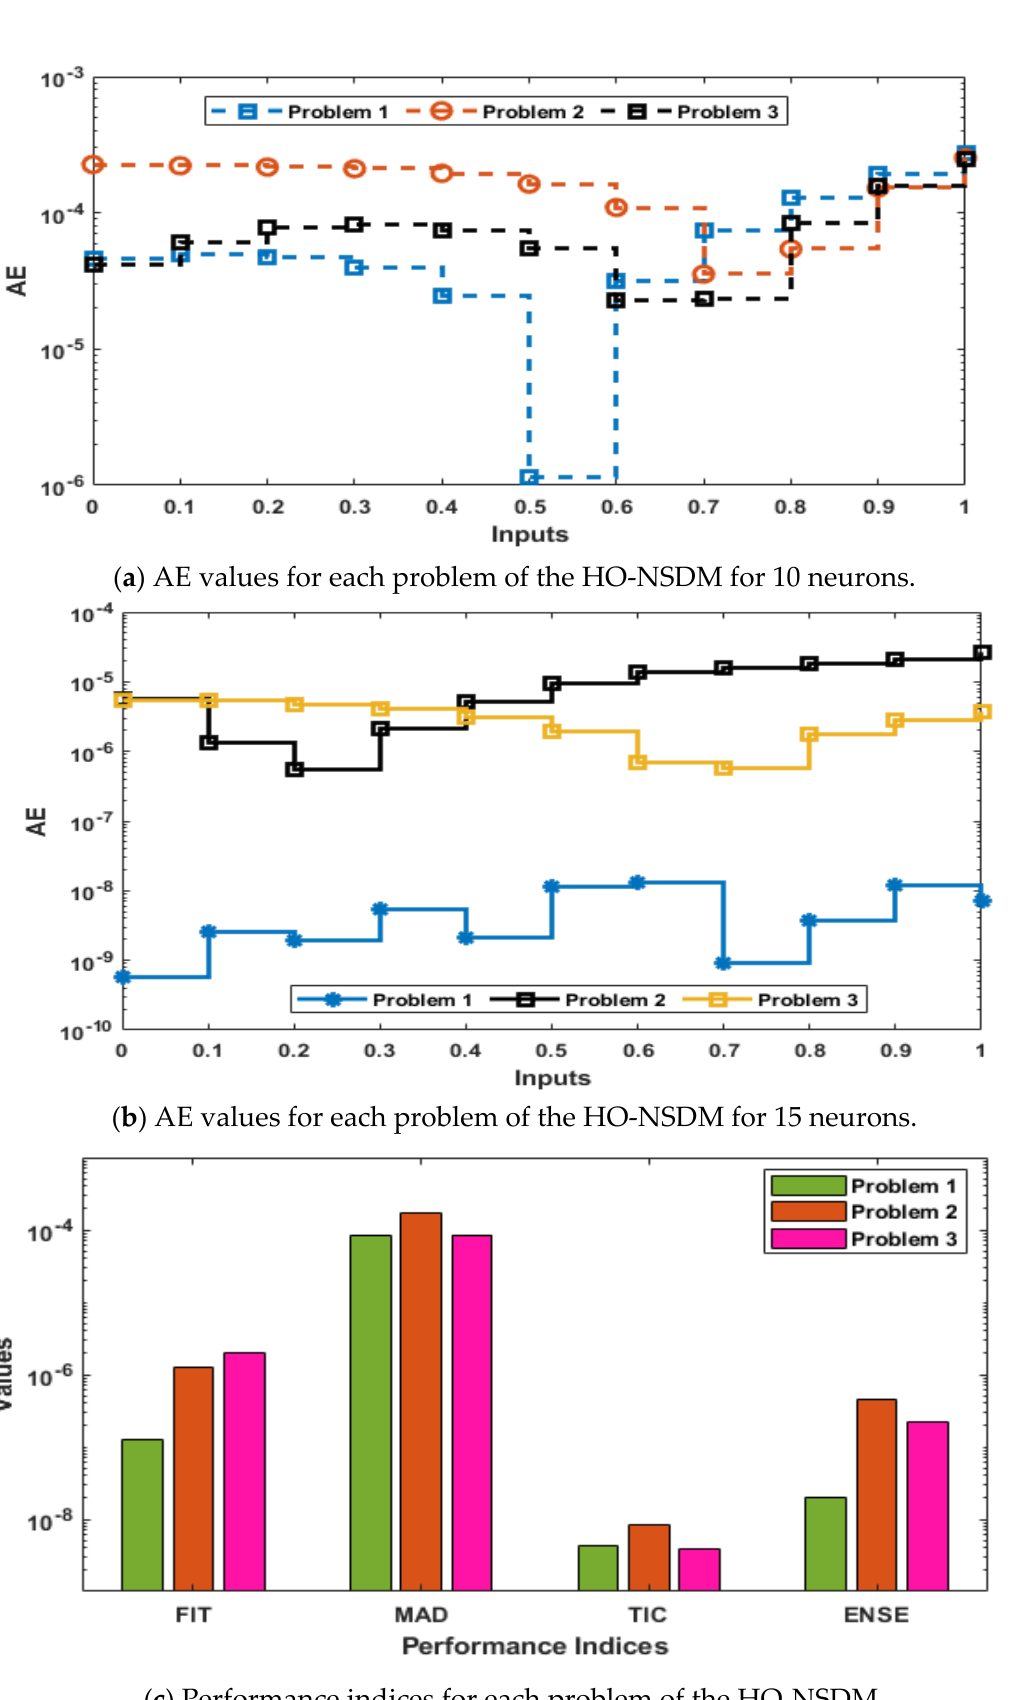
Figure 3. AE and performance indices for each problem of the HO-NSDM.